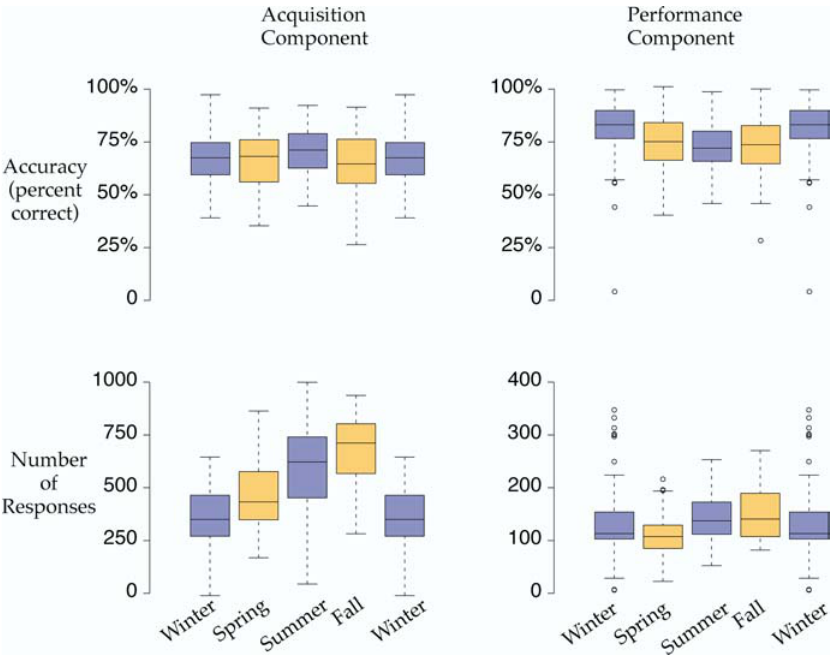
Figure 8. Seasonal Aspects of Operant Behavior Accuracy and the total number of responses during the acquisition task are shown for the 3 wk of spring and fall during which each bird was most active (orange) at night and for the 3 wk during summer and winter during which each bird was the least active (purple) at night. Note that the data for winter are plotted twice to facilitate comparison. In contrast to sleep restric- tion imposed by the experimenters (see Figure 6), sparrows maintained high levels of accuracy on the acquisition and performance tasks during periods of sleep restriction associated with migration. Furthermore, the total num- ber of responses reached the highest values during the fall migration, in contrast to the decline in responding following experimenter-imposed sleep restriction. DOI: